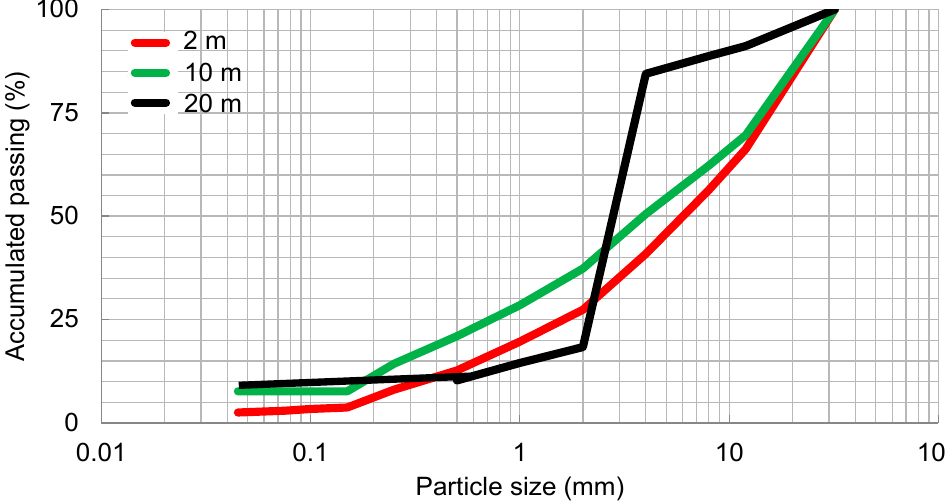
Figure 5. Size distribution of the raw coal samples.